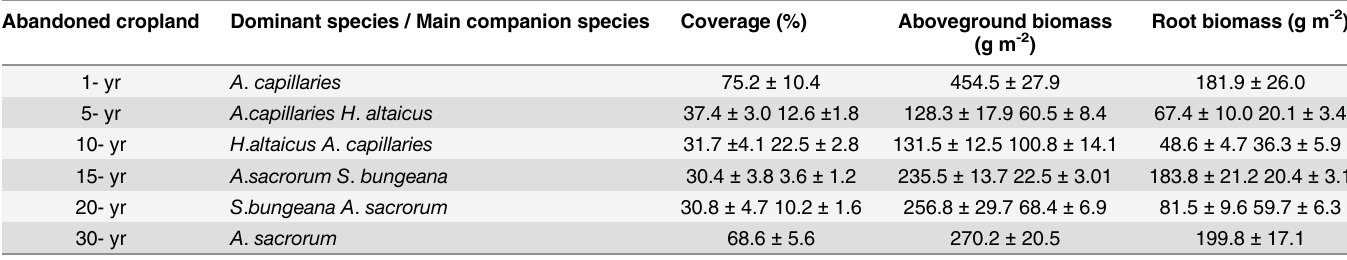
Table 1. Change of plant characteristics during the natural succession